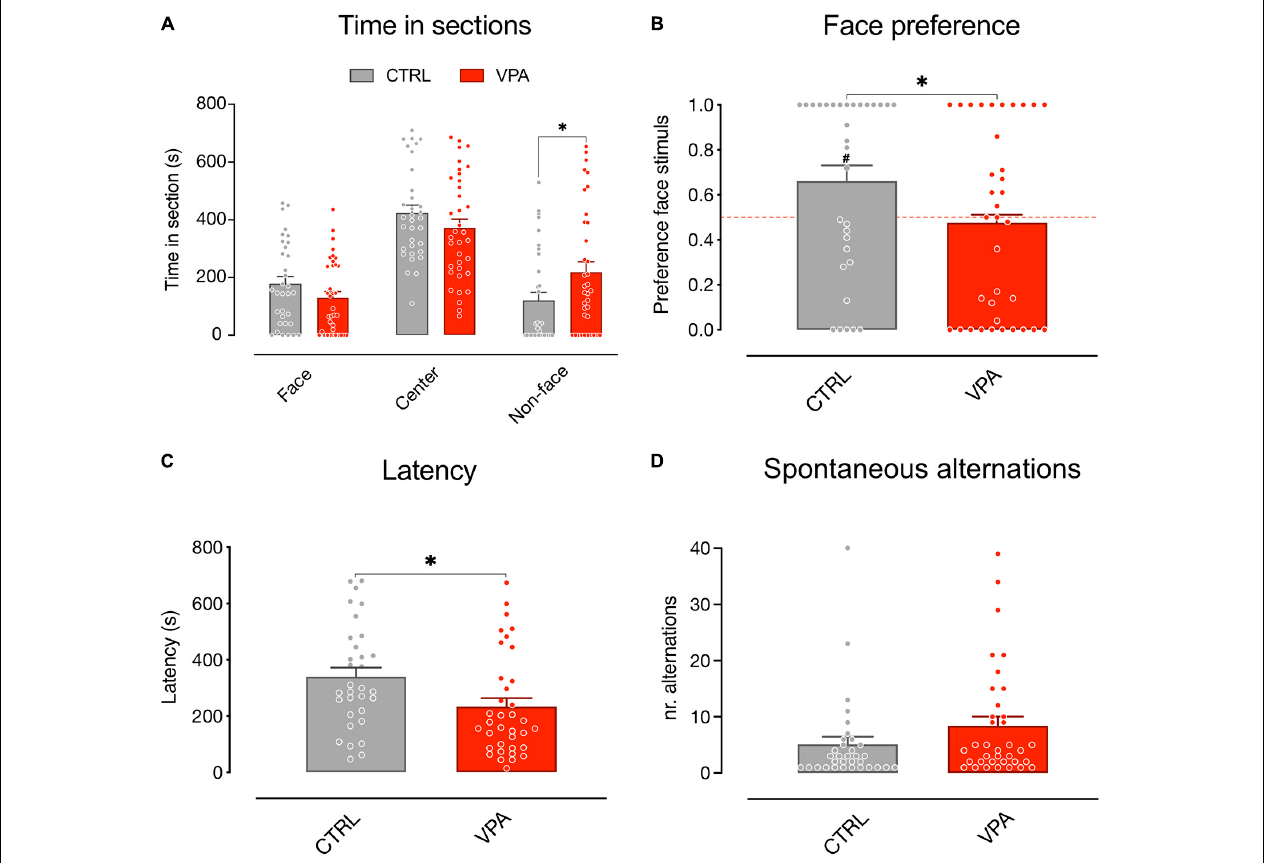
FIGURE 2 | Spontaneous visual preference test. Social preference test for schematic face-like (social) stimulus and non-social stimulus (see “Materials and Methods” for details). Bar graphs represent time spent in the choice sections (A) social preferences indexes (B) , latency to first choice (C) , and spontaneous alternations (D) . (A) Mixed model analysis on the time spent in the three apparatus sections (face, center, and non-face) considering treatment and sex as fixed between subject factors and the time spent in each apparatus section as fixed repeated measures, shows a significant difference in the absolute time spent in the three sections (not shown) and a significant interaction between treatment and time spent in each apparatus section, and no other main effect or interactions between the factors analyzed. Sidak multiple comparison test shows a significant effect of treatment on the time spent in the non-face chamber. (B) Analysis of variance of social preference indexes using treatment and sex as between-subject factors, revealed a significant main effect of treatment and no other main effects or interactions among the factors analyzed. One-sample t -test on preference indexes indicate a significant difference from chance level for the control group, but not for VPA-treated chicks. The number sign (#) indicate significant departures of the preference index from chance level (0.5), marked by the red line. (C) Behavioral activity during the test measured as latency to express a choice. Analysis of variance on time taken by the chicks to move in one of the choice sections using treatment and sex as between-subject factors, showing a significant effect of treatment and no other main effects or interaction. (D) Behavioral activity during the test measured as sections alternations. Analysis of variance on number of alternations between the three sections , using treatment and sex as between-subject factors, showing no significant main effect of treatment or sex, and no interactions. Data represent Mean ± SEM, # p < 0.05, ∗ p <